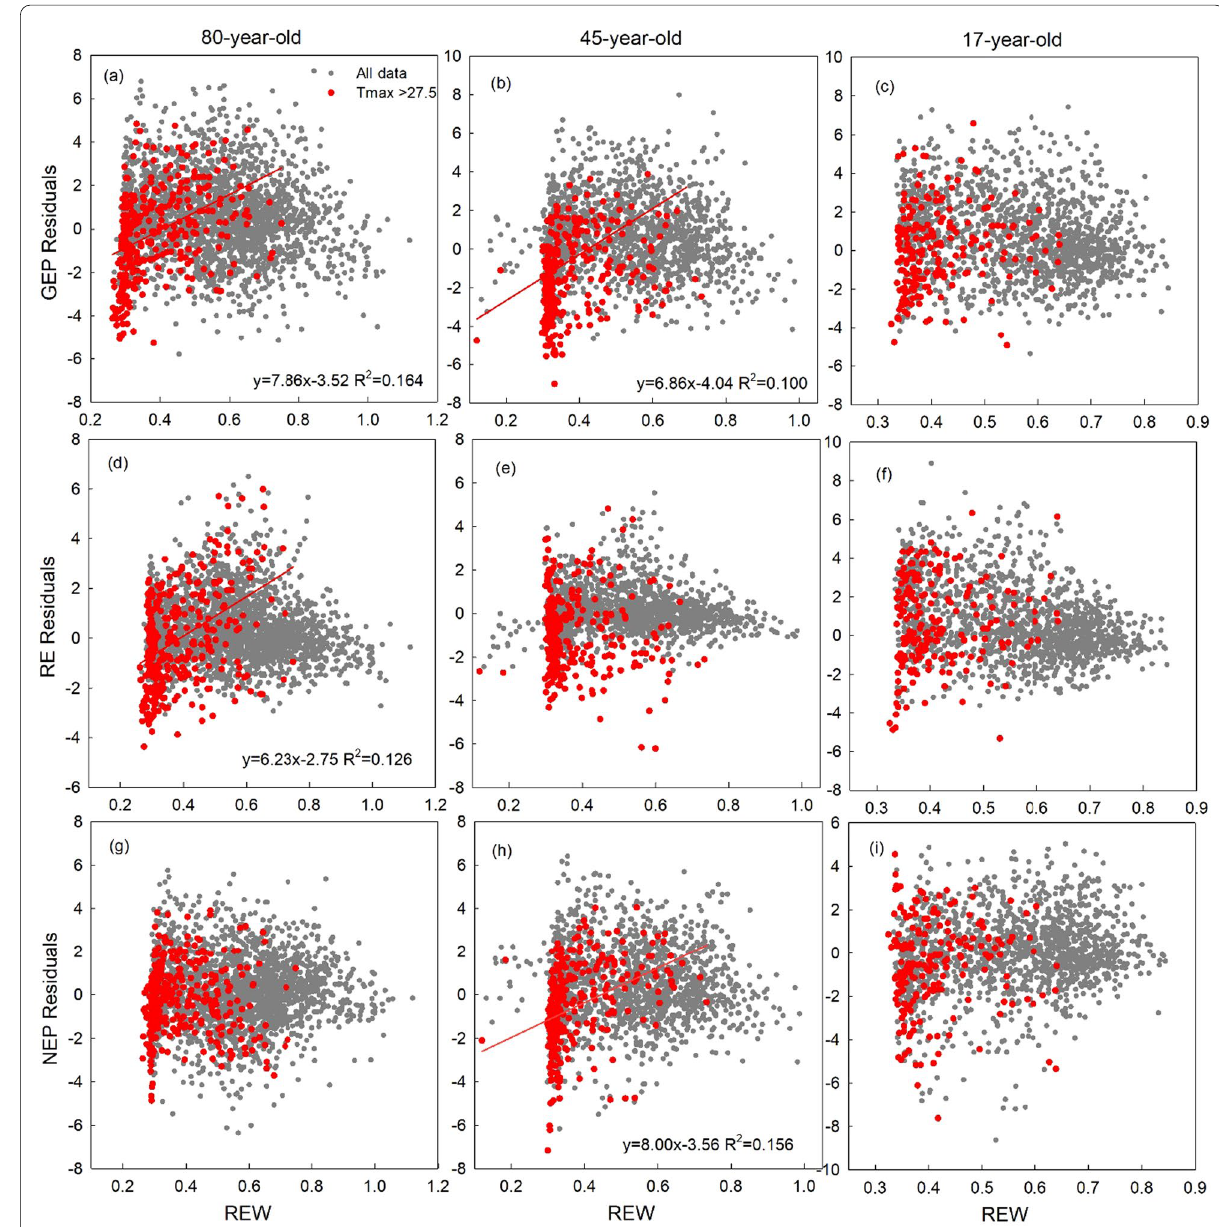
Fig. 7 Correlations between daily gross ecosystem productivity (GEP), ecosystem respiration (RE), and net ecosystem productivity (NEP) residuals of REW using data from all days with no precipitation (gray dots) and using data from only hot days (red dots) with no precipitation. Hot days were defined as those when daily maximum air temperature, T max 27.5 °C. Significant linear regressions at p < 0.01 are shown as solid ≥